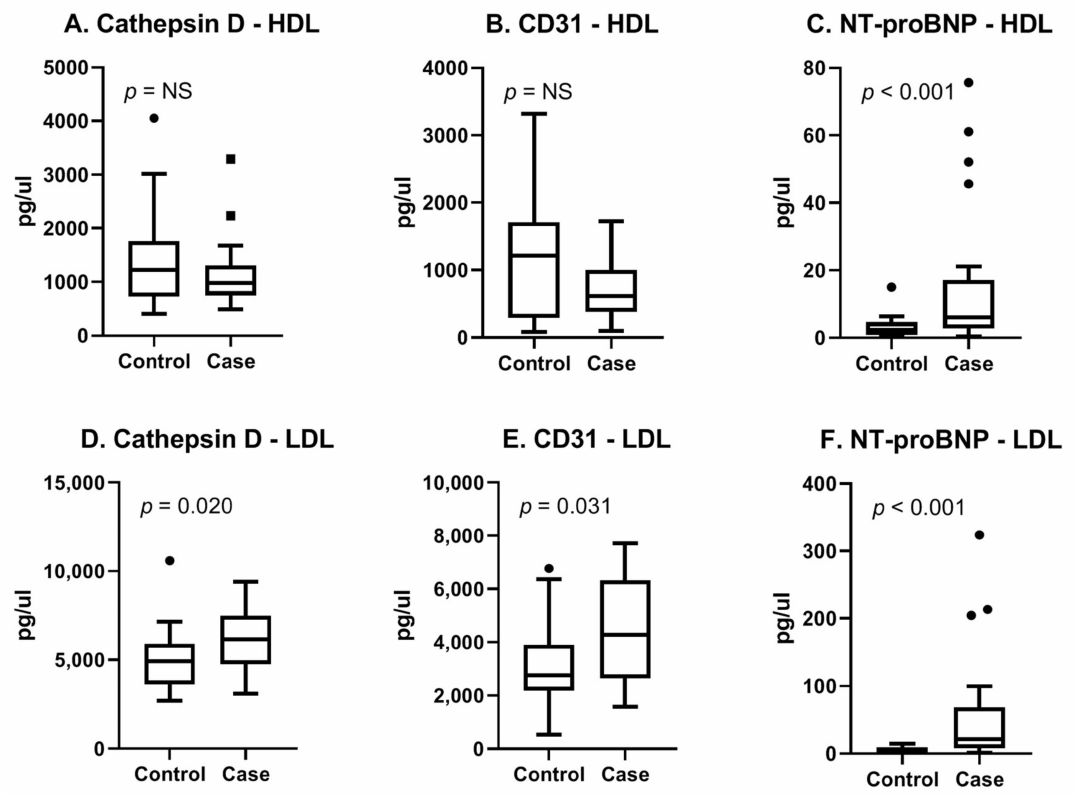
Figure 3. Boxplots of three selected proteins measured with MSD. Assessment of reproducibility of Olink results with a clinically available immunoassay. ( A – C ) HDL and ( D – F ) LDL indicate EV-subpopulations. Cases were 22 male patients with proven CCS and controls were 22 age- and risk-factor-matched patients who were symptomatic without CCS. Original assay units are pg /